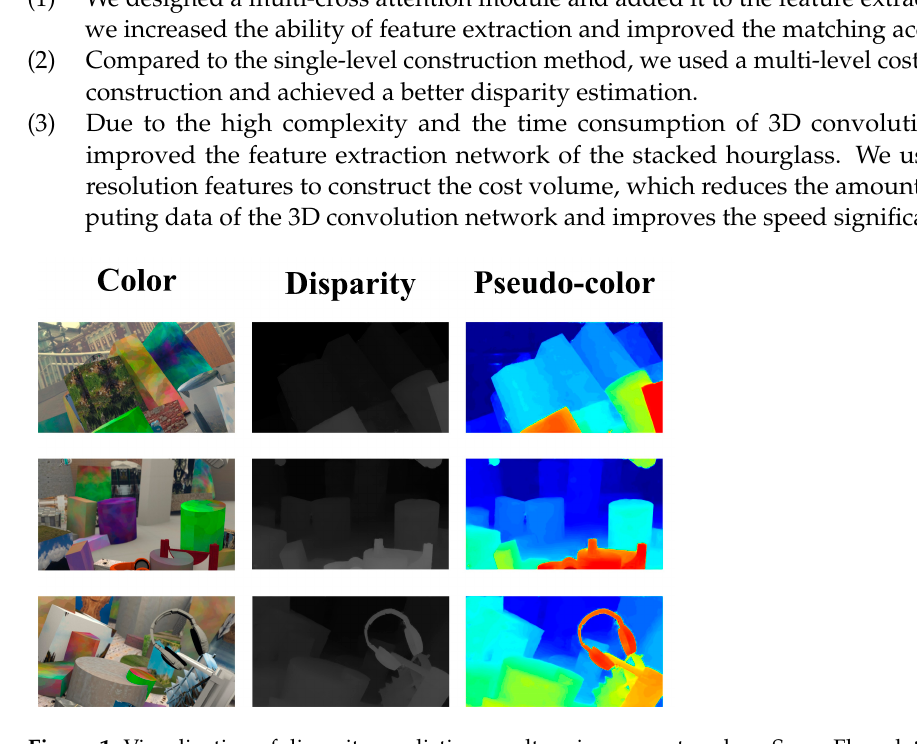
Figure 1. Visualization of disparity prediction results using our network on Scene Flow dataset. The first column is RGB images, the second column is disparity images estimated by our method, and the last column is the pseudo-color disparity images for showing them more clearly.